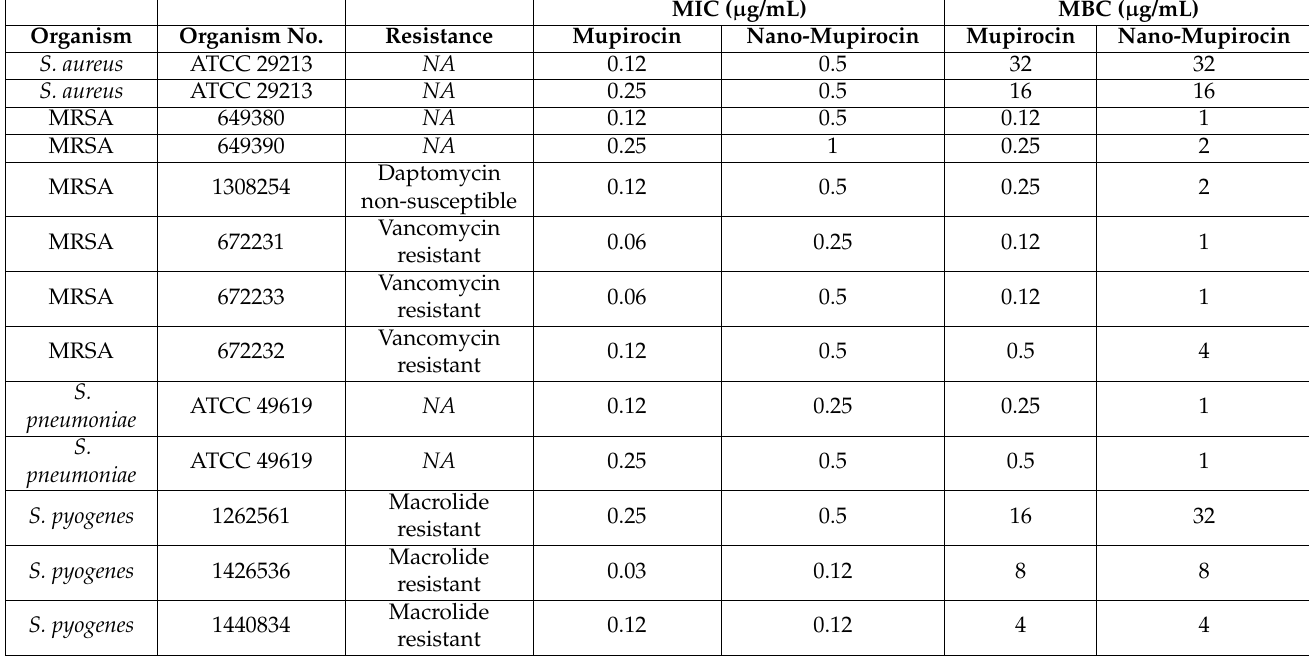
Table 5. MBC vs. MIC of mupirocin and Nano-mupirocin for reference strains of S. aureus and Streptococcus spp. MIC ( µ g/mL) MBC ( µ g/mL) Organism Organism No. Resistance Mupirocin Nano-Mupirocin Mupirocin